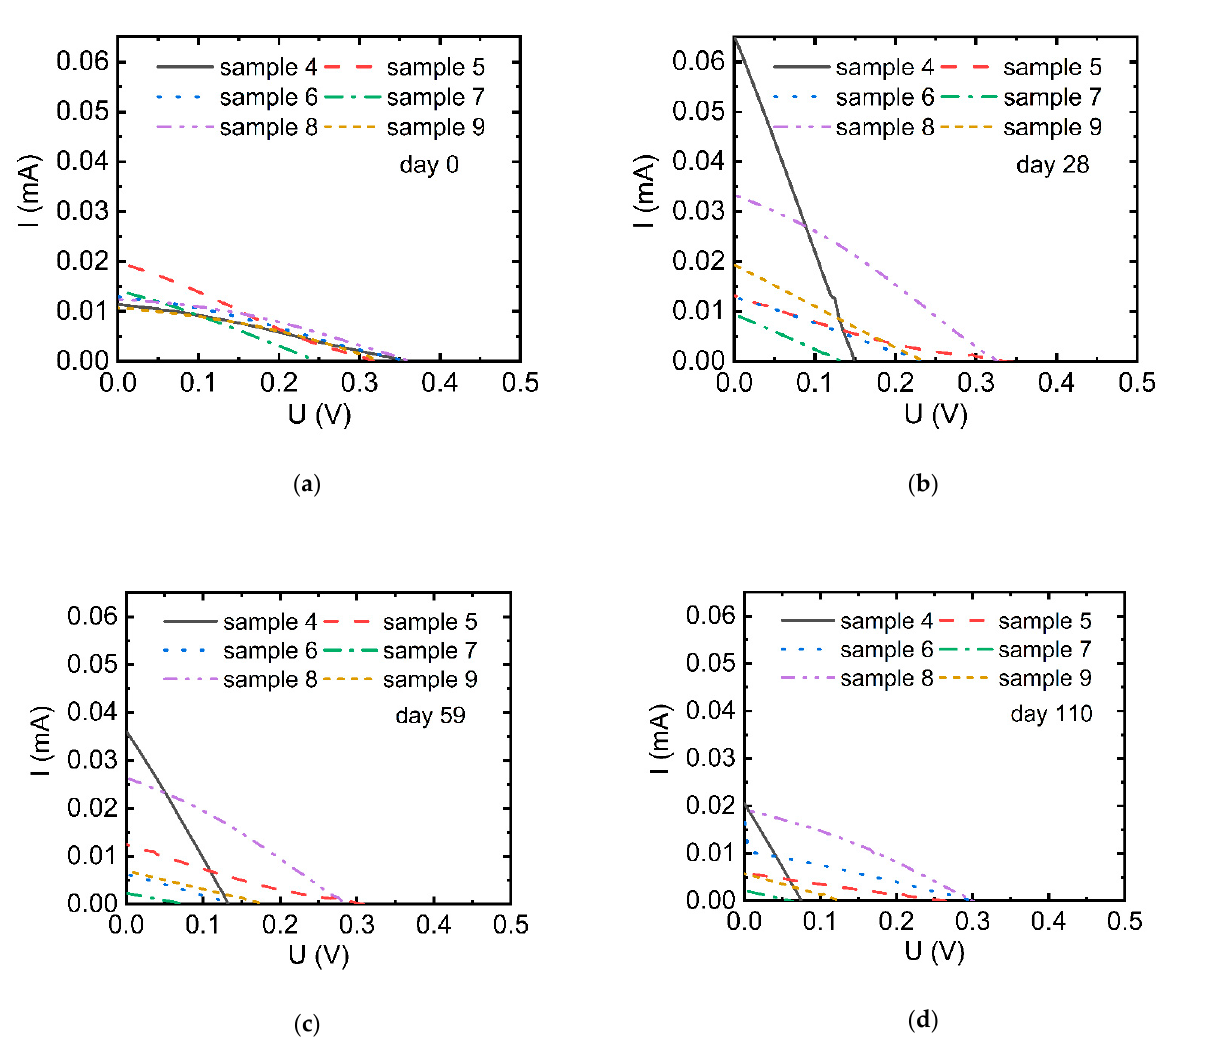
Figure 5. I-U curves of ABS blended with PEO (sample 4), ABS (sample 5), PVA blended with PEO (sample 6), PVA (sample 7), and PVDF blended with PEO (sample 8) and PVDF (sample 9) GPEs for: ( a ) day 0; ( b ) day 28; ( c ) day 59; and ( d ) day 110.